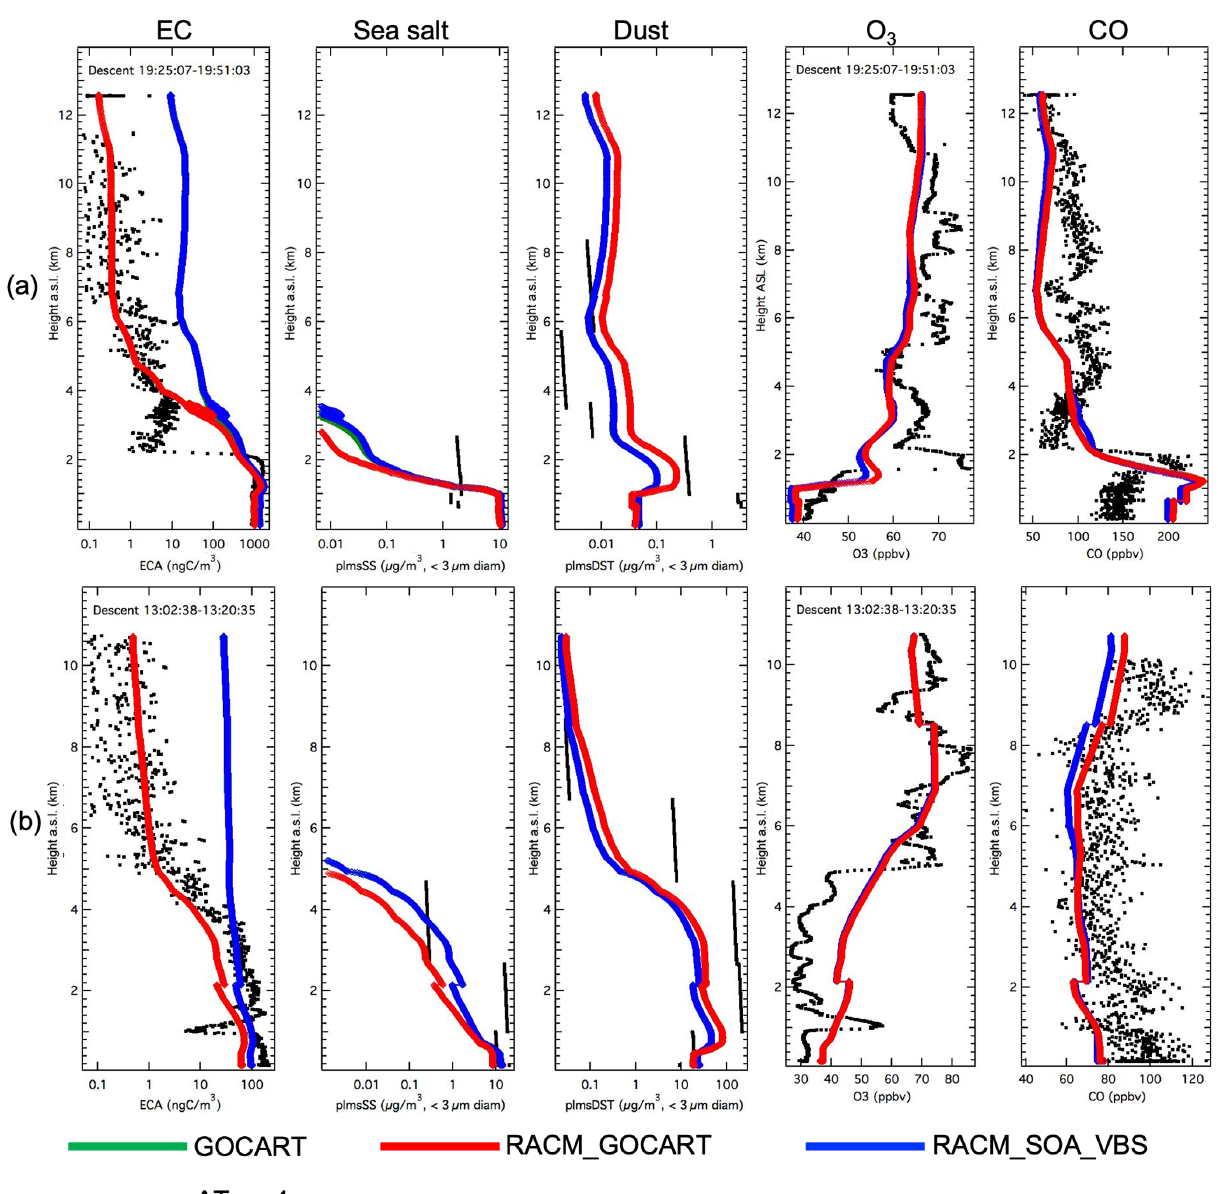
Figure 9. Comparisons between ATom-1 observations and model vertical profiles of EC, sea salt, dust, O 3 , and CO in the (a) biomass burning and (b) dust storm events. The biomass burning plume is from 15 August 2016, profile no. 16 near 20 ◦ S, while the Saharan dust plume is from 17 August 2016, profile no. 10 near 25 ◦ N. Green and blue lines are nearly identical for